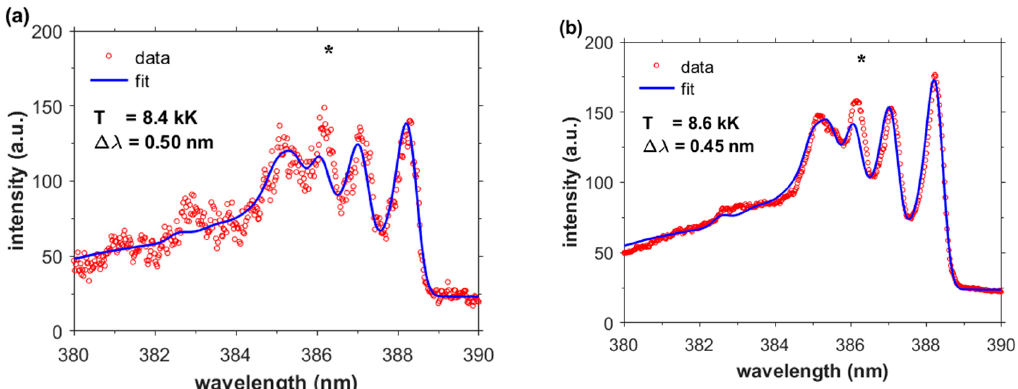
Figure 7. Inferred CN excitation temperature ( a ) at the center, ( b ) at a radius of 0.85 mm, 1.2-µs time delay, gate 0.125 µs. The asterisks indicate the 386.2-nm position for the 193.1-nm carbon line measured in 2nd order.